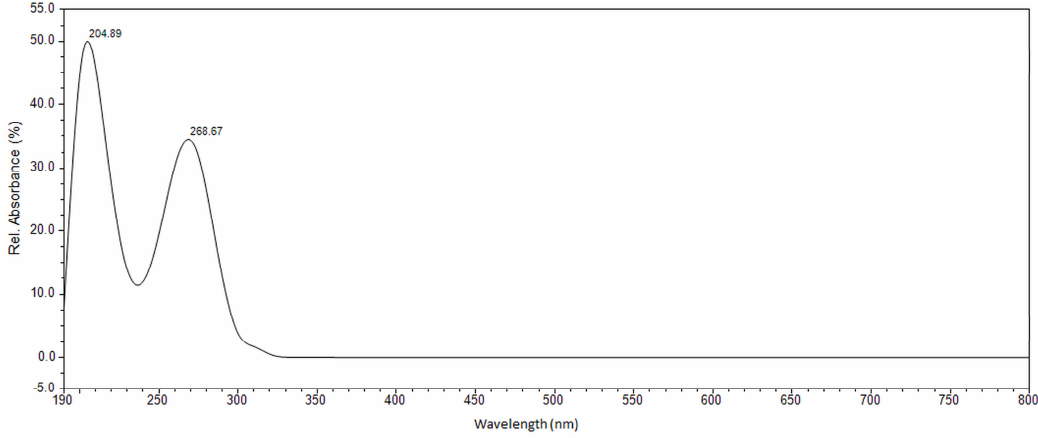
Figure 8. Absorption spectrum of